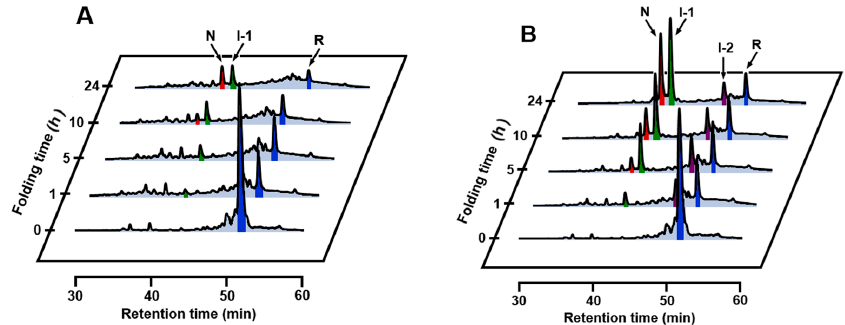
Figure 3. RP-HPLC chromatograms obtained by the oxidation of R (10 µM) with 1 eq DHS ox at pH 8.0 and 5 °C in the absence of EDTA. The reaction was acid-quenched after 0, 1, 5, 10, and 24 h. For HPLC analysis conditions, see the experimental section: ( A ) in the absence of CaCl 2 ; ( B ) in the presence of 5 mM CaCl 2 .